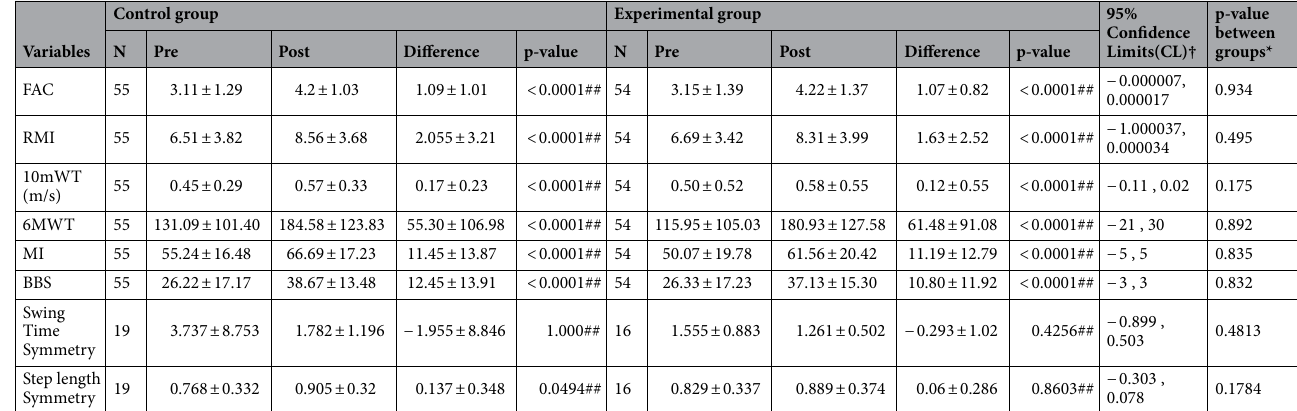
Table 2. The difference of outcome changes in the experimental and control group. FAC functional ambulation categories, RMI rivermead mobility index, 10mWT 10-meter walk test, 6MWT 6-minute walk test, MI motricity index, BBS berg balance scale. # p-value obtained from Paired t-test. ## p-value obtained from Wilcoxon signed rank test. † CL obtained from Wilcoxon’s rank sum test. *p-value obtained from Wilcoxon rank sum